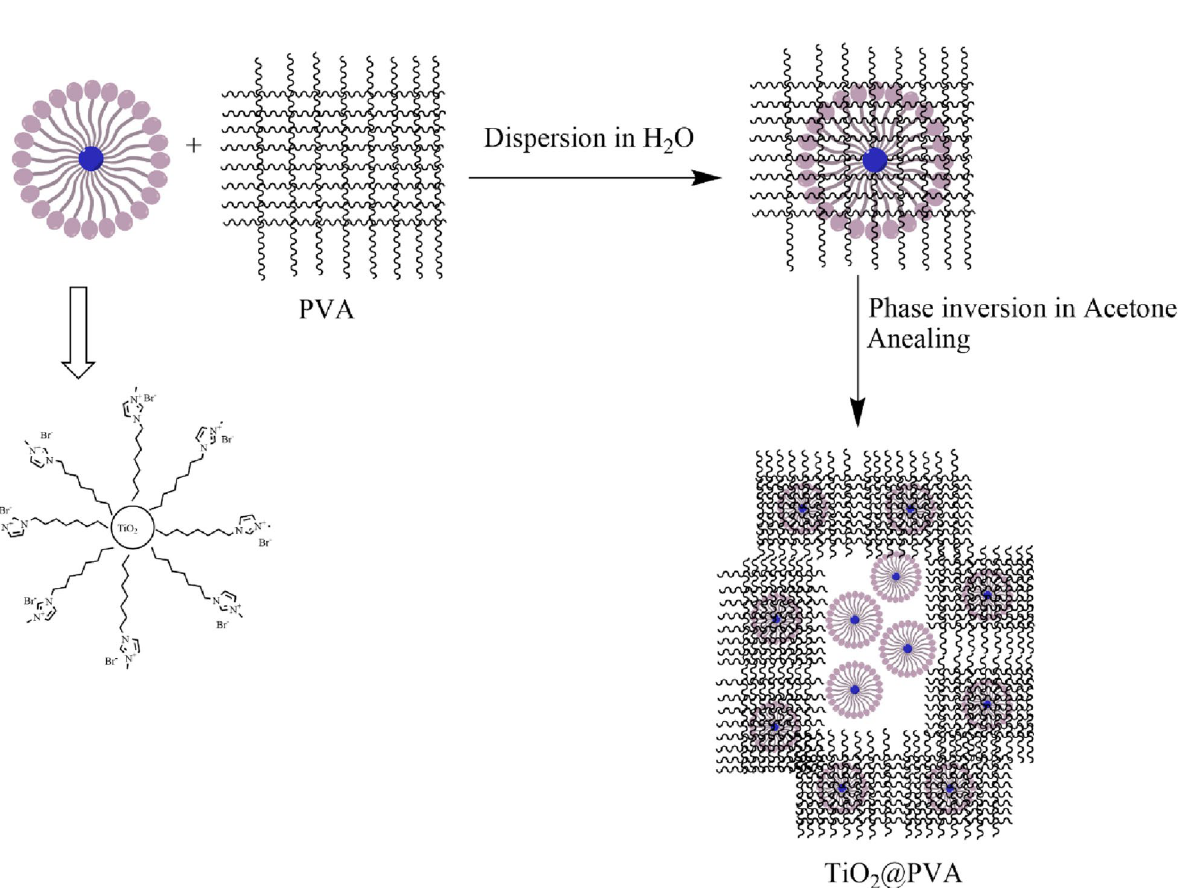
Figure 11. Suggested mechanism for the synthesis of hallow and porous TiO2@PVA